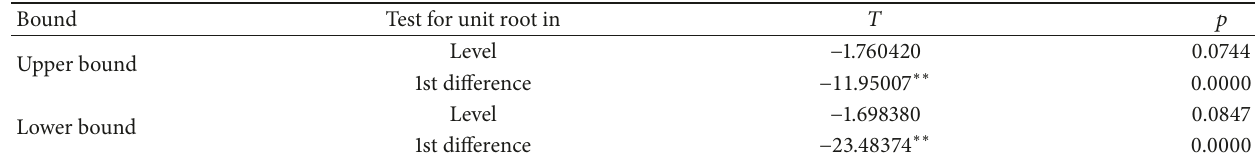
Table 4: ADF test results.